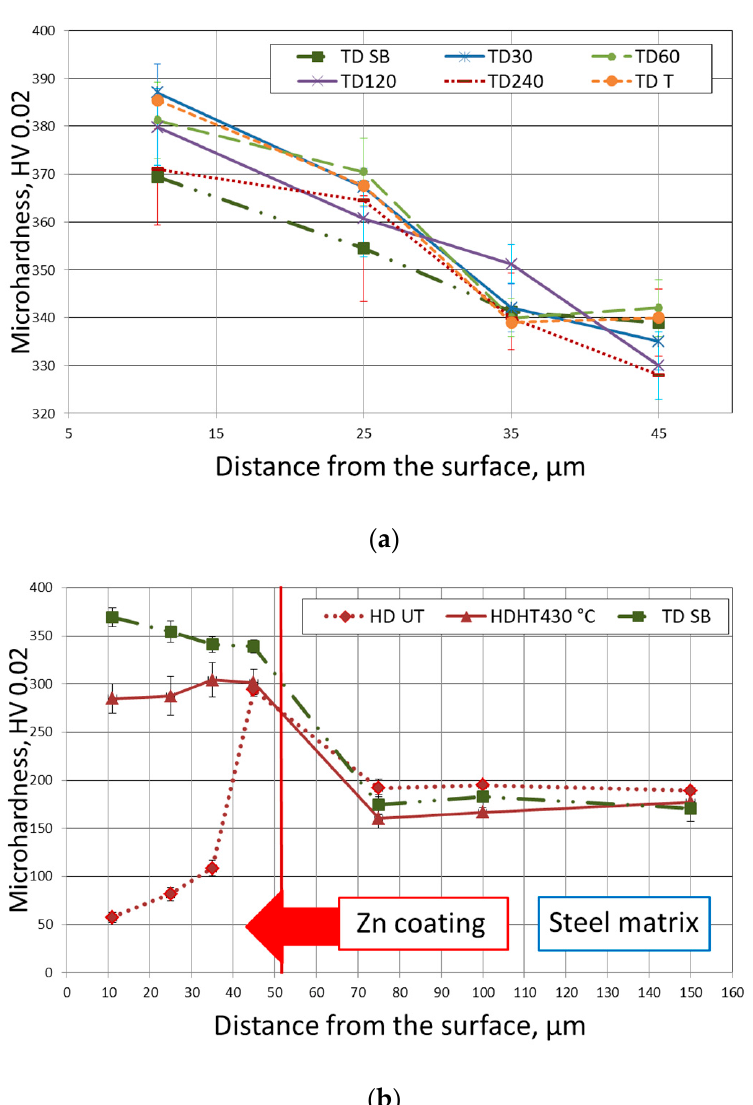
Figure 6. Microhardness measured at the cross section of the TD zinc coating deposited on disc- shaped steel samples ( a ) and comparison of obtained results to the microhardness measured after HD galvanizing—untreated (HD UT)—and after heat treatment at 430 ° (HD HT 430 °C) ( b ). The presented hardness changes are due to the changes in the microstructure ( Г 1 + δ – suggested by results of EDS analysis), caused by diffusion of iron from the steel surface into the coating (Figure 2, Table 2). The hardness values measured by Pokorny [25] show that the δ phase is generally about 10% harder than the Г phase; the obtained hardness values of the δ phase were even in the range 330 to 460 HV. According to data [16,46], the δ phase in TD coating is harder by about 15% than the Г phase. In the analysed results of the current study, the difference is within the range 10–12%, but the coating micro-cracks may affect the measured hardness values and can have a decisive importance